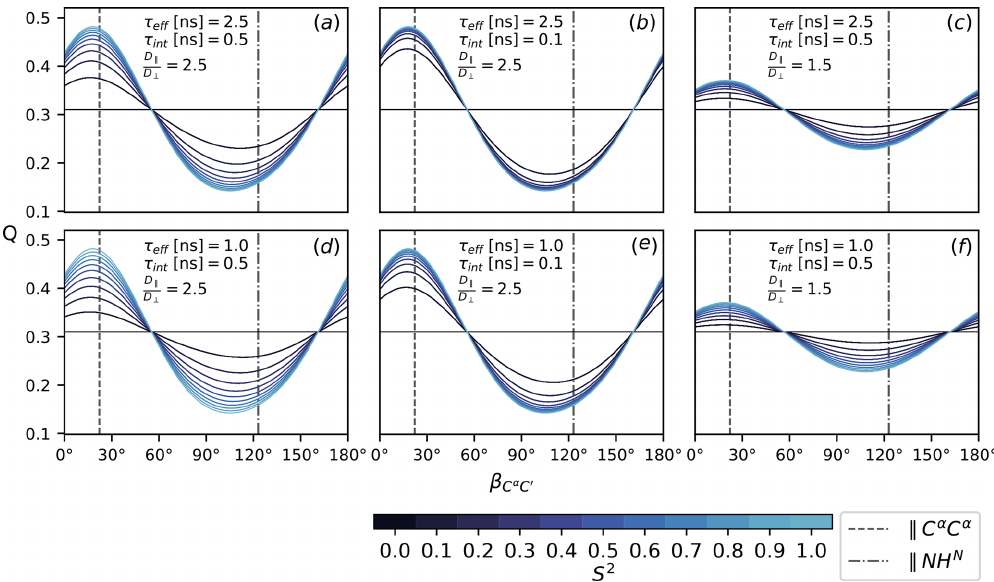
Figure 4. The ratio Q , Eq. (16), as a function of the diffusion tensor orientation denoted by β C α C (cid:48) , Fig. 2. Dashed lines indicate the orientation of the NH N and the C α C α vector. All rates are calculated according to Eqs. (7), (8), (11), (12)–(15) with τ − 1 Order parameters from 0 and 1 are color-coded. Panels (a–f) show Q for different choices of τ eff , τ int and B 0 , is the same for all